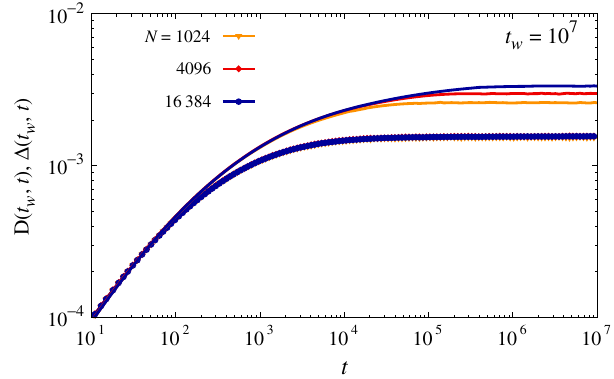
; t Þ (lines) and cage-relative MSD FIG. 2. Full MSD D ð t w Δ ð t ; t Þ (symbols) measured at pressure Z ¼ 100 for various w ¼ 10 7 . The strong system sizes N ¼ 1024 , 4096, 16384, with t w finite size effects due to Mermin-Wagner fluctuations are re- moved by using cage-relative coordinates. We use cage-relative quantities for all